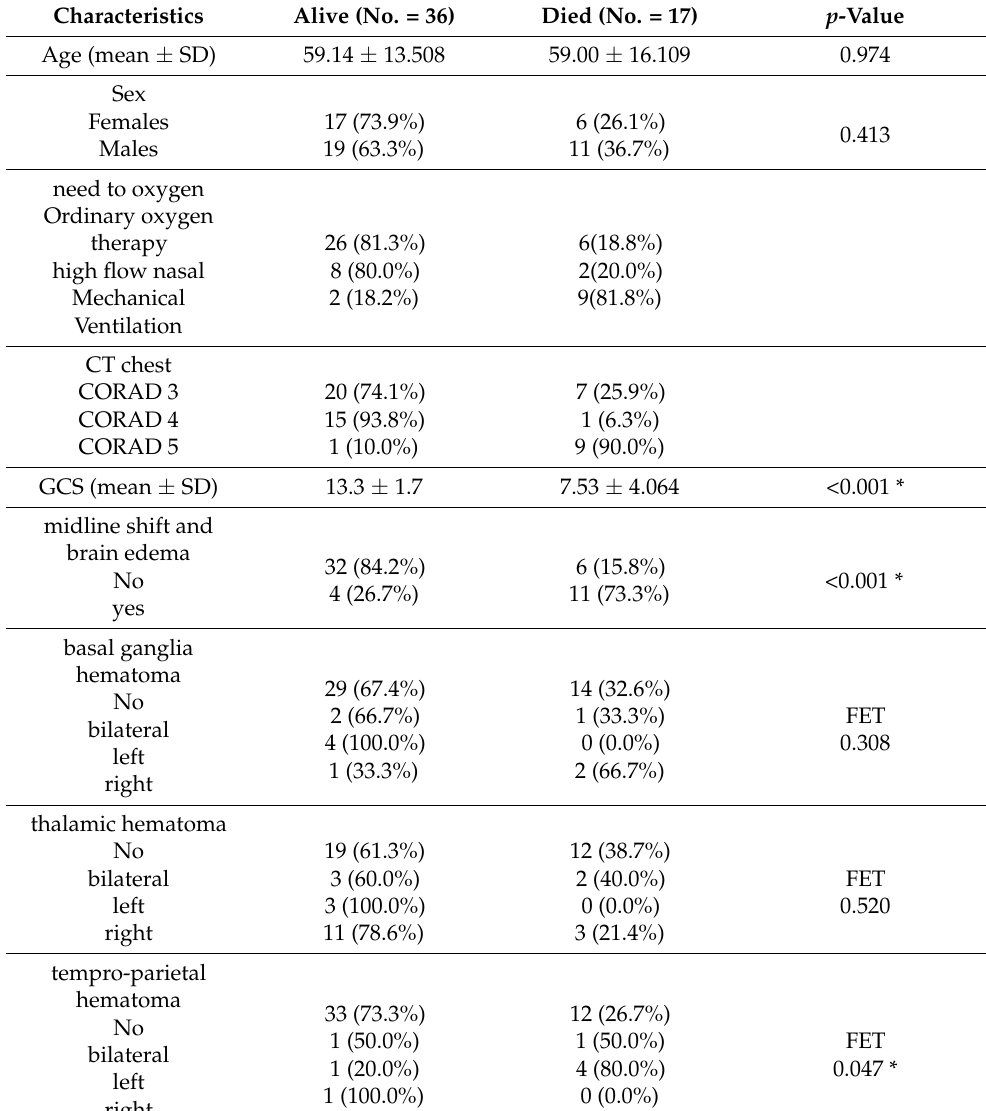
Table 5. Relations between mortality and different patients’ characteristics.